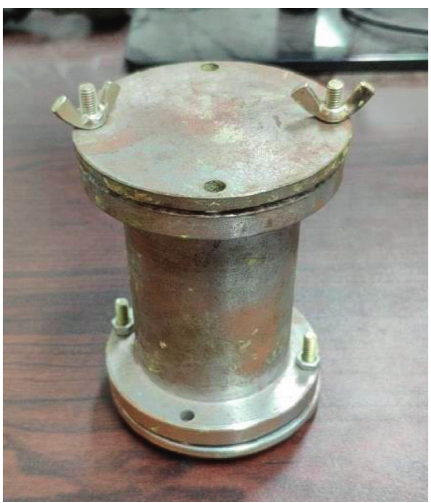
Figure 1: Self-made specimen